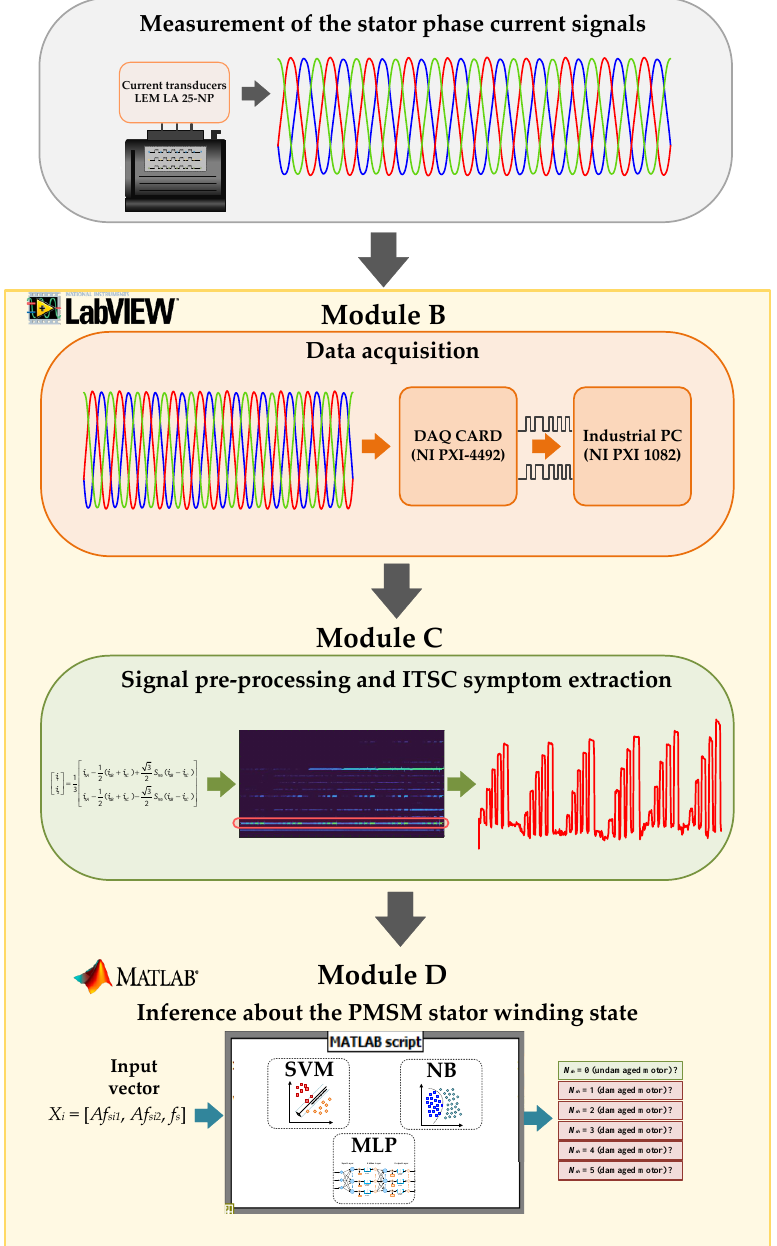
Figure 23. Structured flowchart of the intelligent diagnosis system of the PMSM stator winding faults concept.